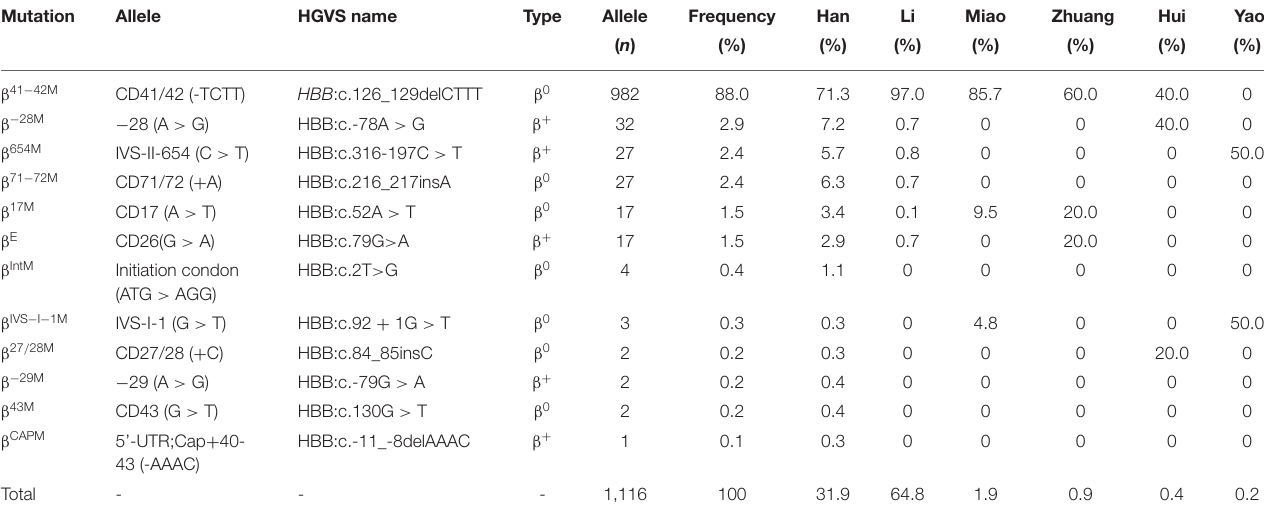
TABLE 5 | Allele frequency of β -thalassemia in the southern area of Hainan. Mutation